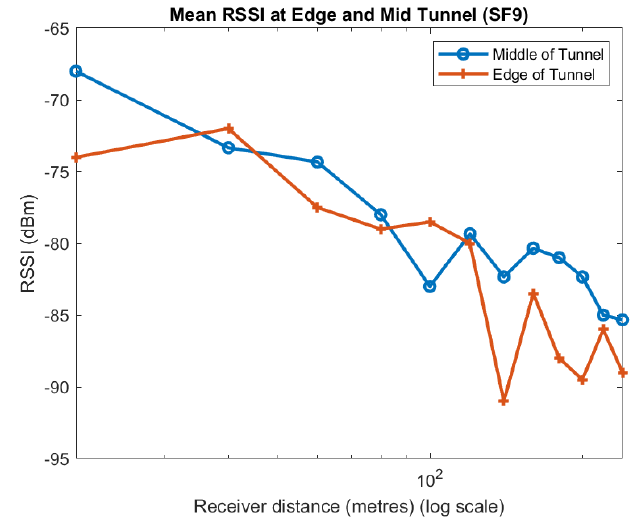
Figure 10. Effect of position in tunnel on RSSI: SF9.